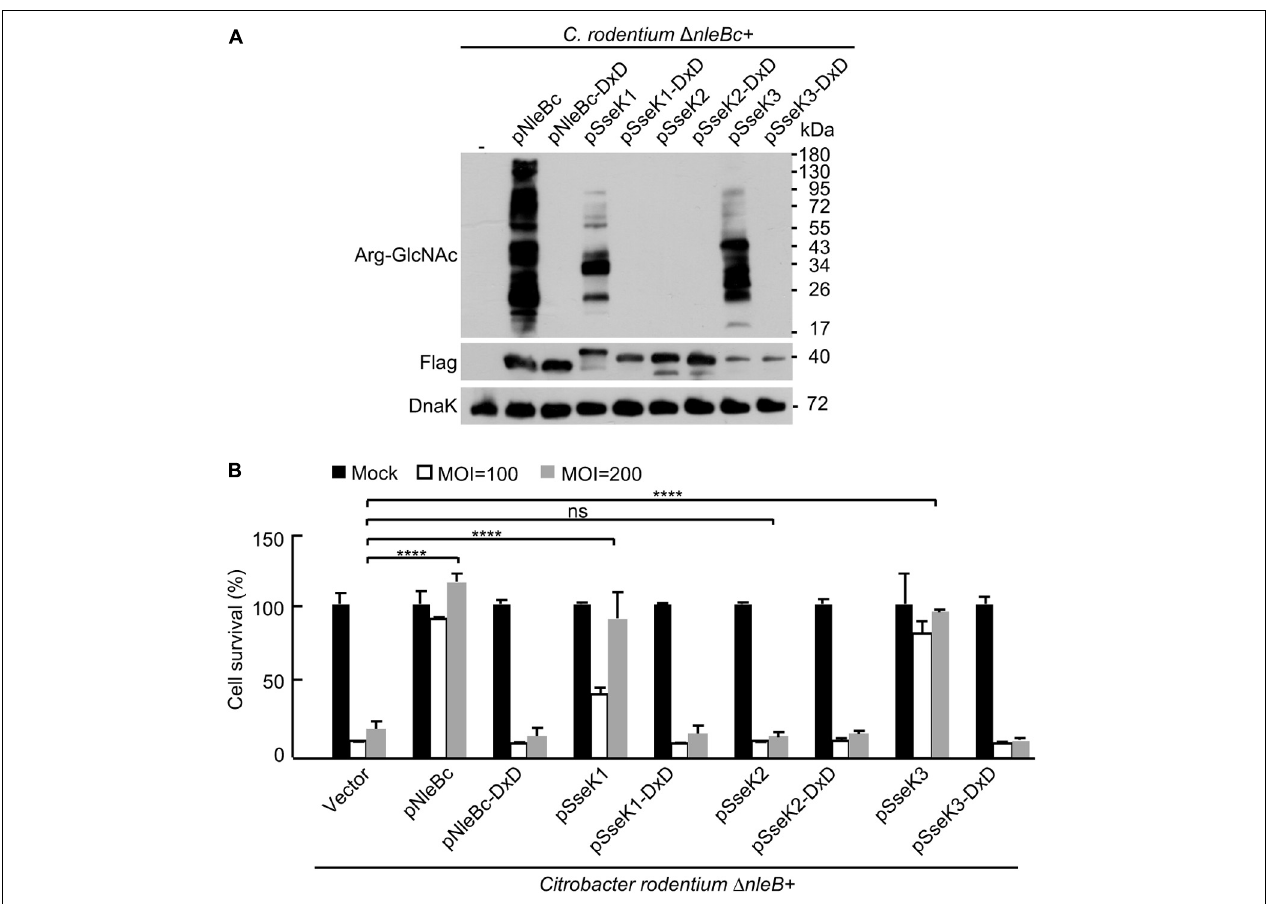
FIGURE 4 | Chimera SseK1 and chimera SseK3 inhibits TNF-induced cell death during C. rodentium infection on MEF cells. (A) Complementation strains of (cid:49) nleB with Citrobacter NleBc or chimera SseK1/2/3 and their enzyme inactivated mutants were generated. Single colony of each strain was inoculated and incubated overnight with the corresponding antibiotics. Bacterial lysates were collected and samples were loaded onto SDS-PAGE gels, followed by standard immunoblotting analysis. (B) NleB and SseK1/3 mediate inhibition of TNF-induced cell death in MEF cells during C. rodentium infection. MEF cells infected with derivatives of C. rodentium strains were stimulated with TNF. Cell viability was determined by measuring ATP levels. **** P < 0.0001 (one-way ANOVA), ns, not statistically significant. Data are representative from at least three repetitions.